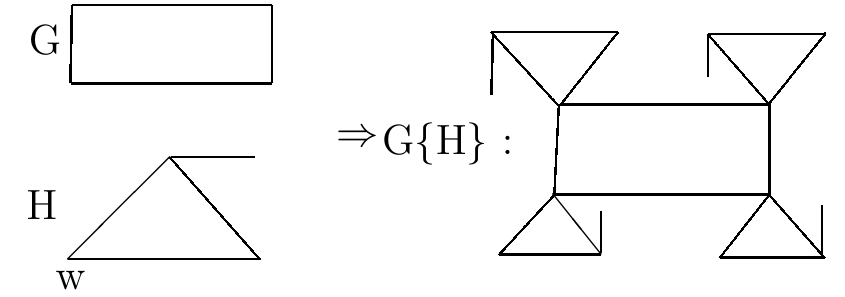
Figure 1. The rooted product of G and H where w is the root of H